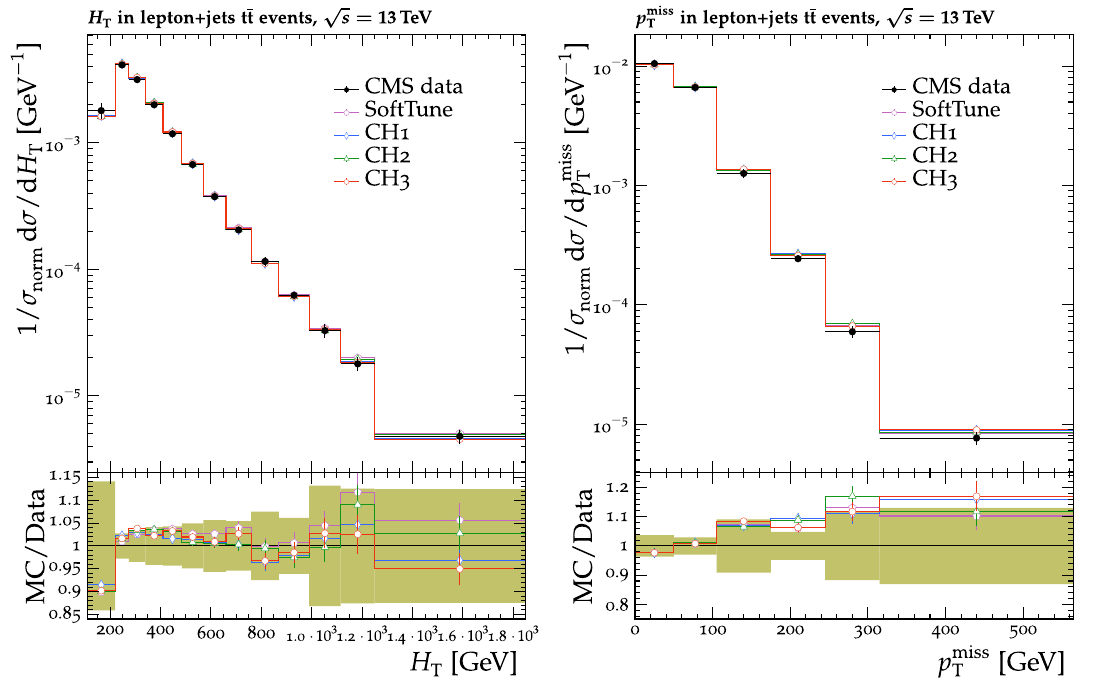
CH3 tunes.Thecolouredbandintheratioplotrepresentsthetotalexper- imental uncertainty in the data. The vertical bars on the points for the different predictions represent the statistical